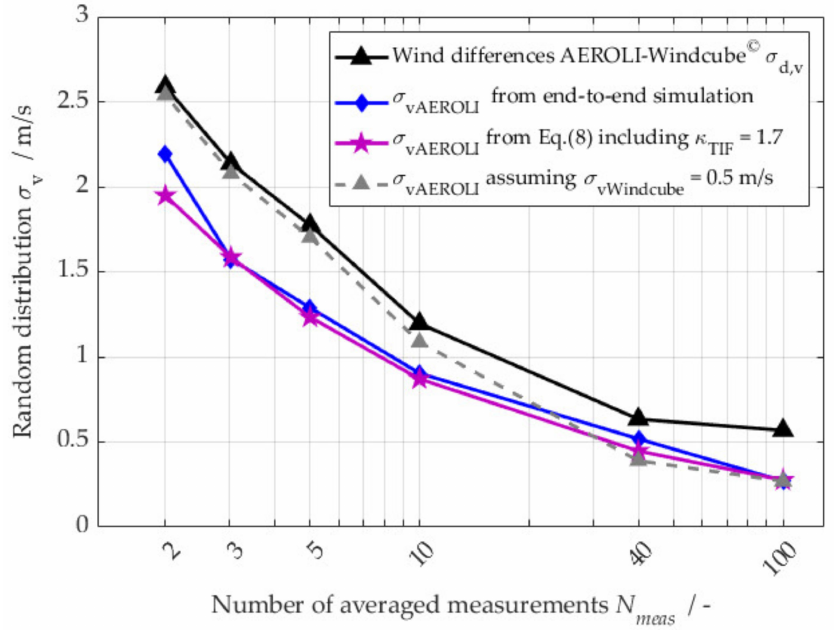
Figure 11. Analysis of the AEROLI demonstrator performance for different averaging times, along with theoretical (simulative) results (modified excerpt from Figure 5.16 in [38]). Details in the